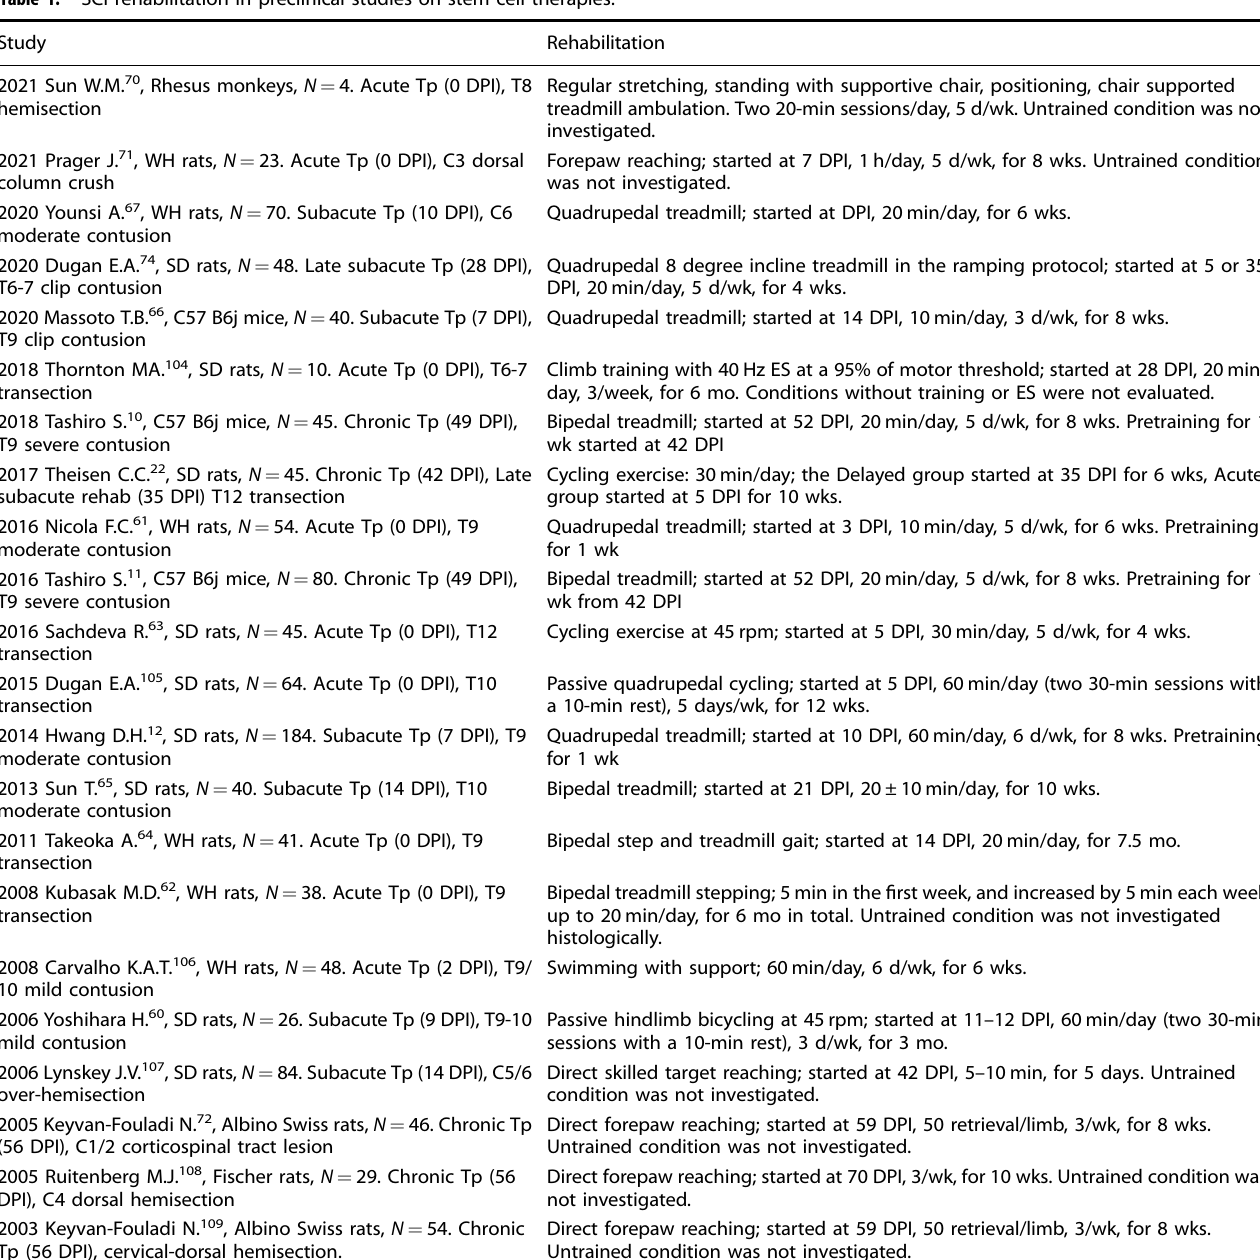
Table 1. SCI rehabilitation in preclinical studies on stem cell therapies. Study